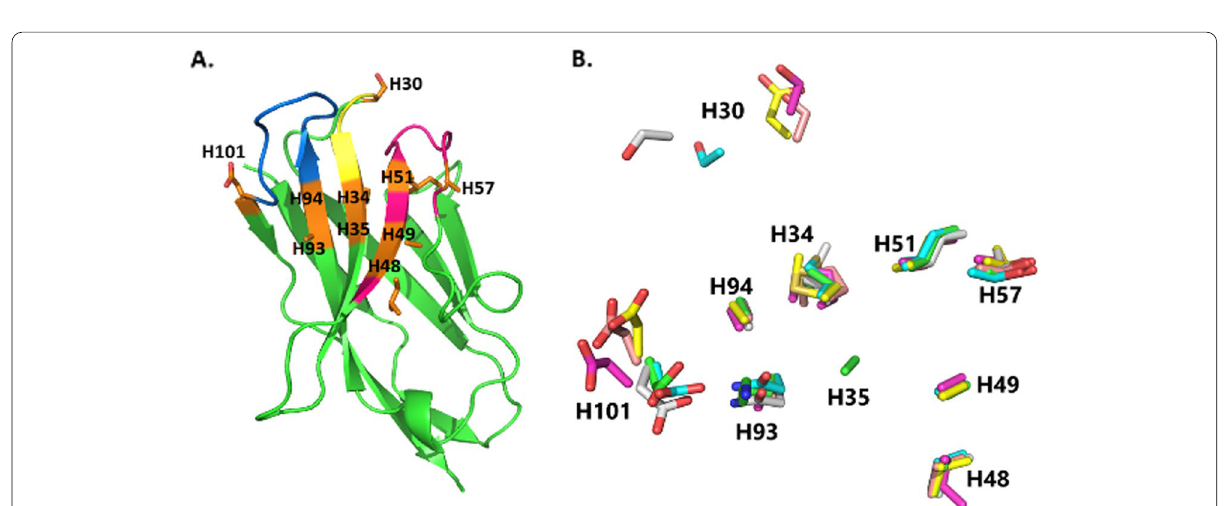
Fig. 6 Key CDR positions of a Nb. A Crystal structure of a Nb with highlighted positions, yellow: CDR1, red: CDR2, blue: CDR3. B Side-chain coordination of six superimposed Nb structures. Each numbered position could comprise more than one kind of amino acid. H30: 4 S, 1 D, 1 G; H34: 6 M; H35: 5 G, 1 A; H48: 5V, 1L; H49: 6A; H51: 6I, H57: 5T, 1A; H93: 3A, 2N, 1K; H94: 6A; H101: